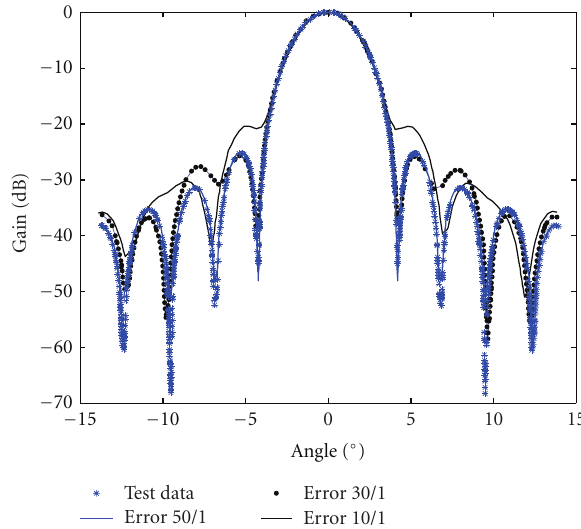
Figure 6: Comparison of the test data and results of the proposed method. Figure 7: Comparison of the di ff erent amplitude error to the test